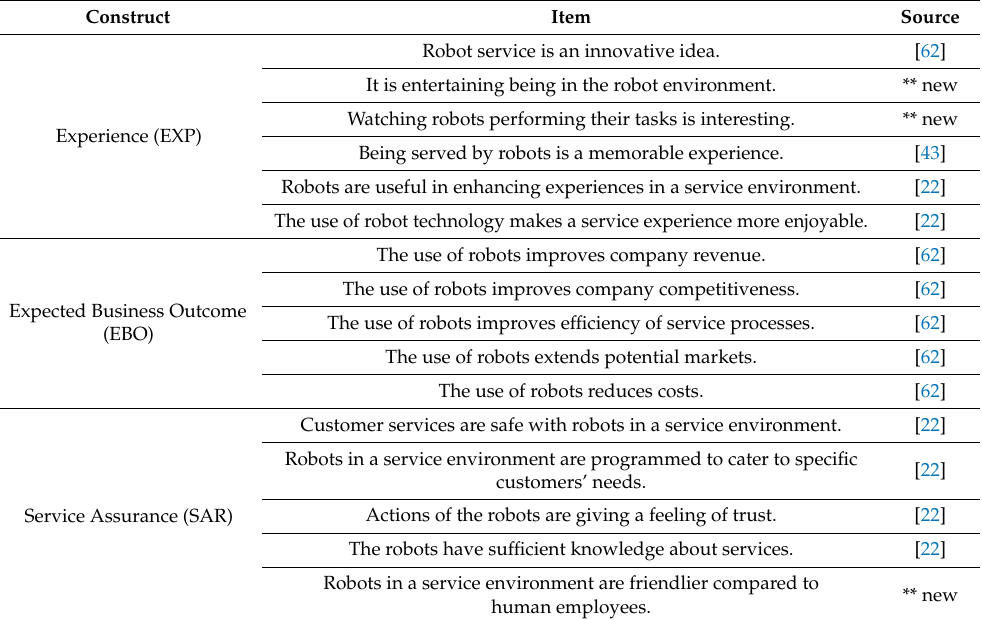
Table 1. Constructs and